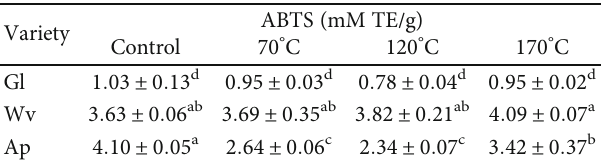
Table 4: ABTS radical scavenging capacity of thermally treated leafy vegetables